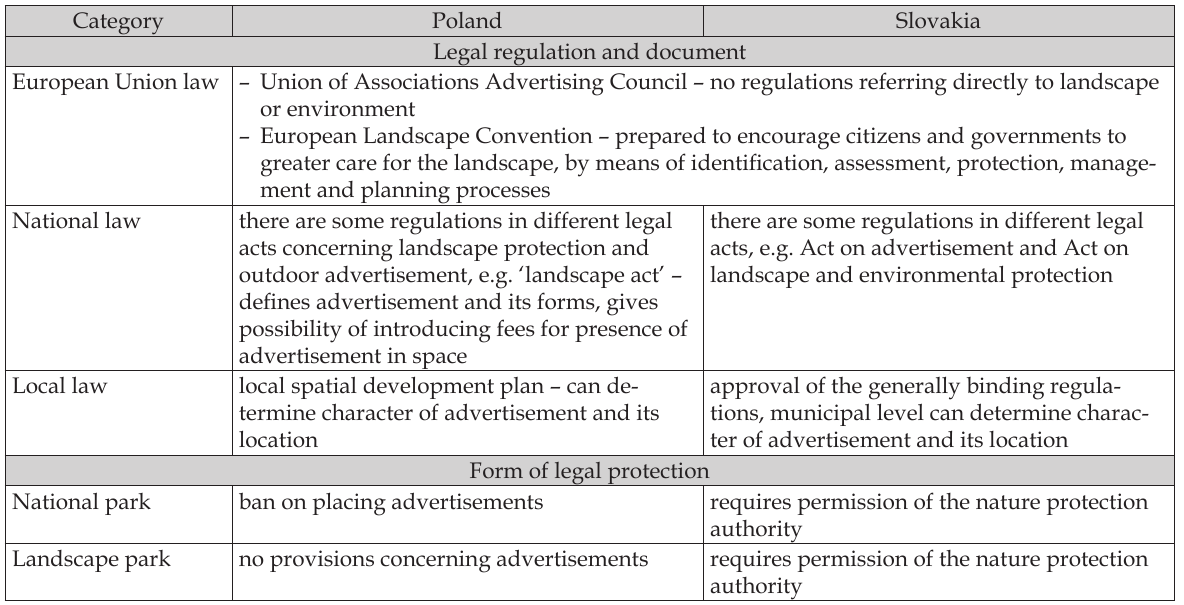
Table 2. Comparison of the legal system and advertising policy regarding protection forms in Polish and Slo- vak